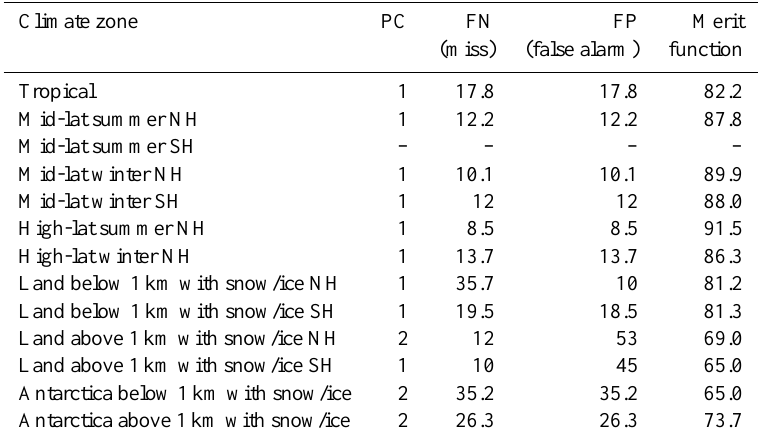
Table 6. CDA results based on coinciding training and validation data sets for night-time soundings over land. The percentage of hit or success (TP) and of correct non-events (TN) can be obtained by 100 − FP and 100 − FN,